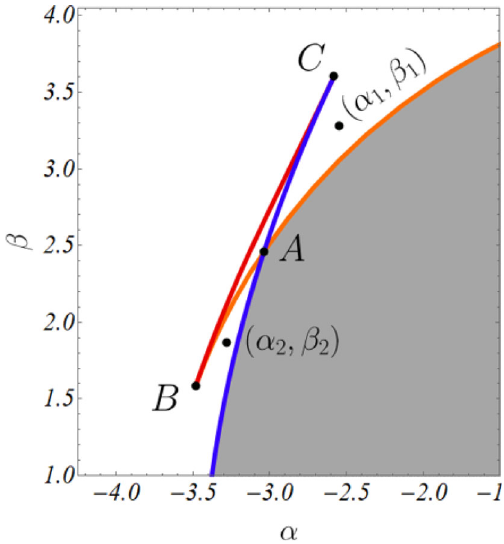
Fig. 8 Behavior of the spherical orbits in the vicinity of the shadow ( 1 ) ≈ 0 . 07.Geodesicswithimpactparam- cuspforspinparameter a > a crit eters (α 1 ,β 1 ) and (α 2 ,β 2 ) scatter away to infinity, and do not give a contribution to the shadow